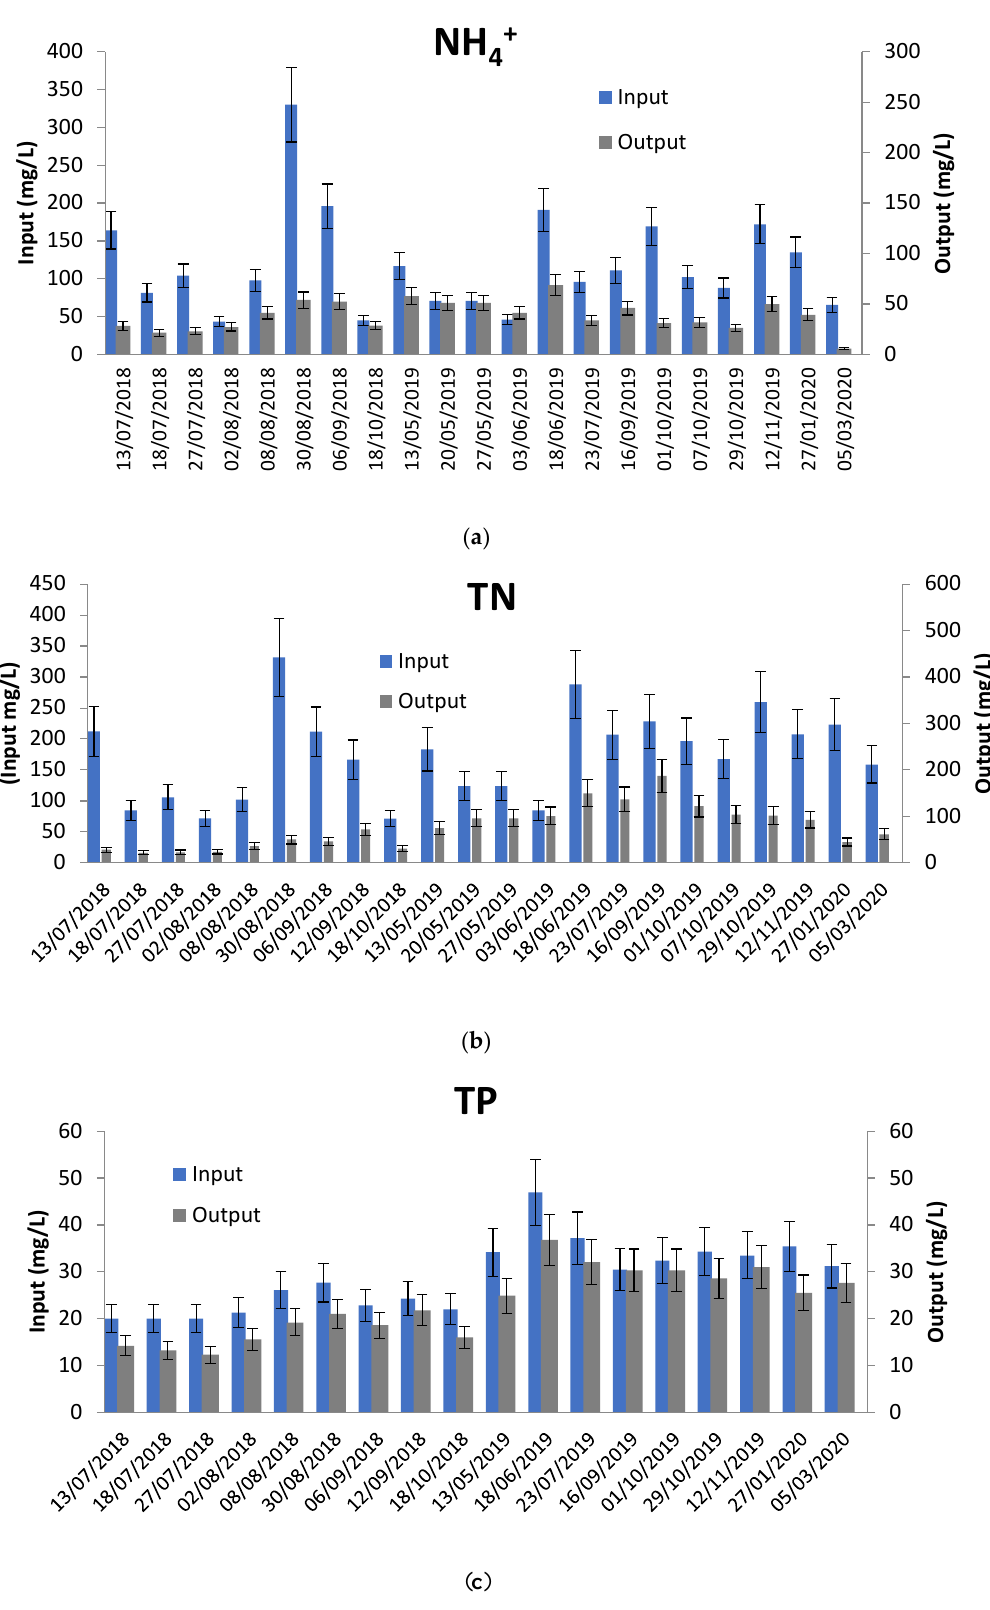
Figure 4. Nutrient concentrations at the input and the output of the plant. Blue bars show input concentration to the plant and grey bars output concentration of the HUSB. ( a ) Ammonia (NH 4 + ); ( b ) total nitrogen (TN); ( c ) total phosphorous